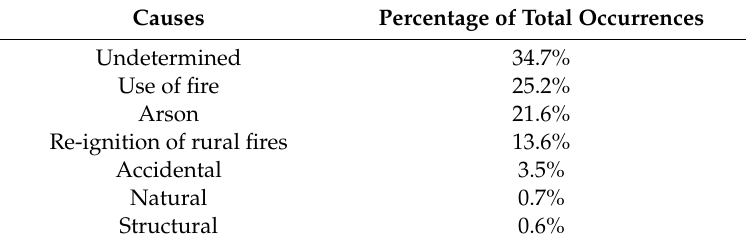
Table 3. Causes of rural fires investigated by National Republican Guard / Nature and Environment Protection Survey (GNR / SEPNA) in 2016 (adapted from [20]).